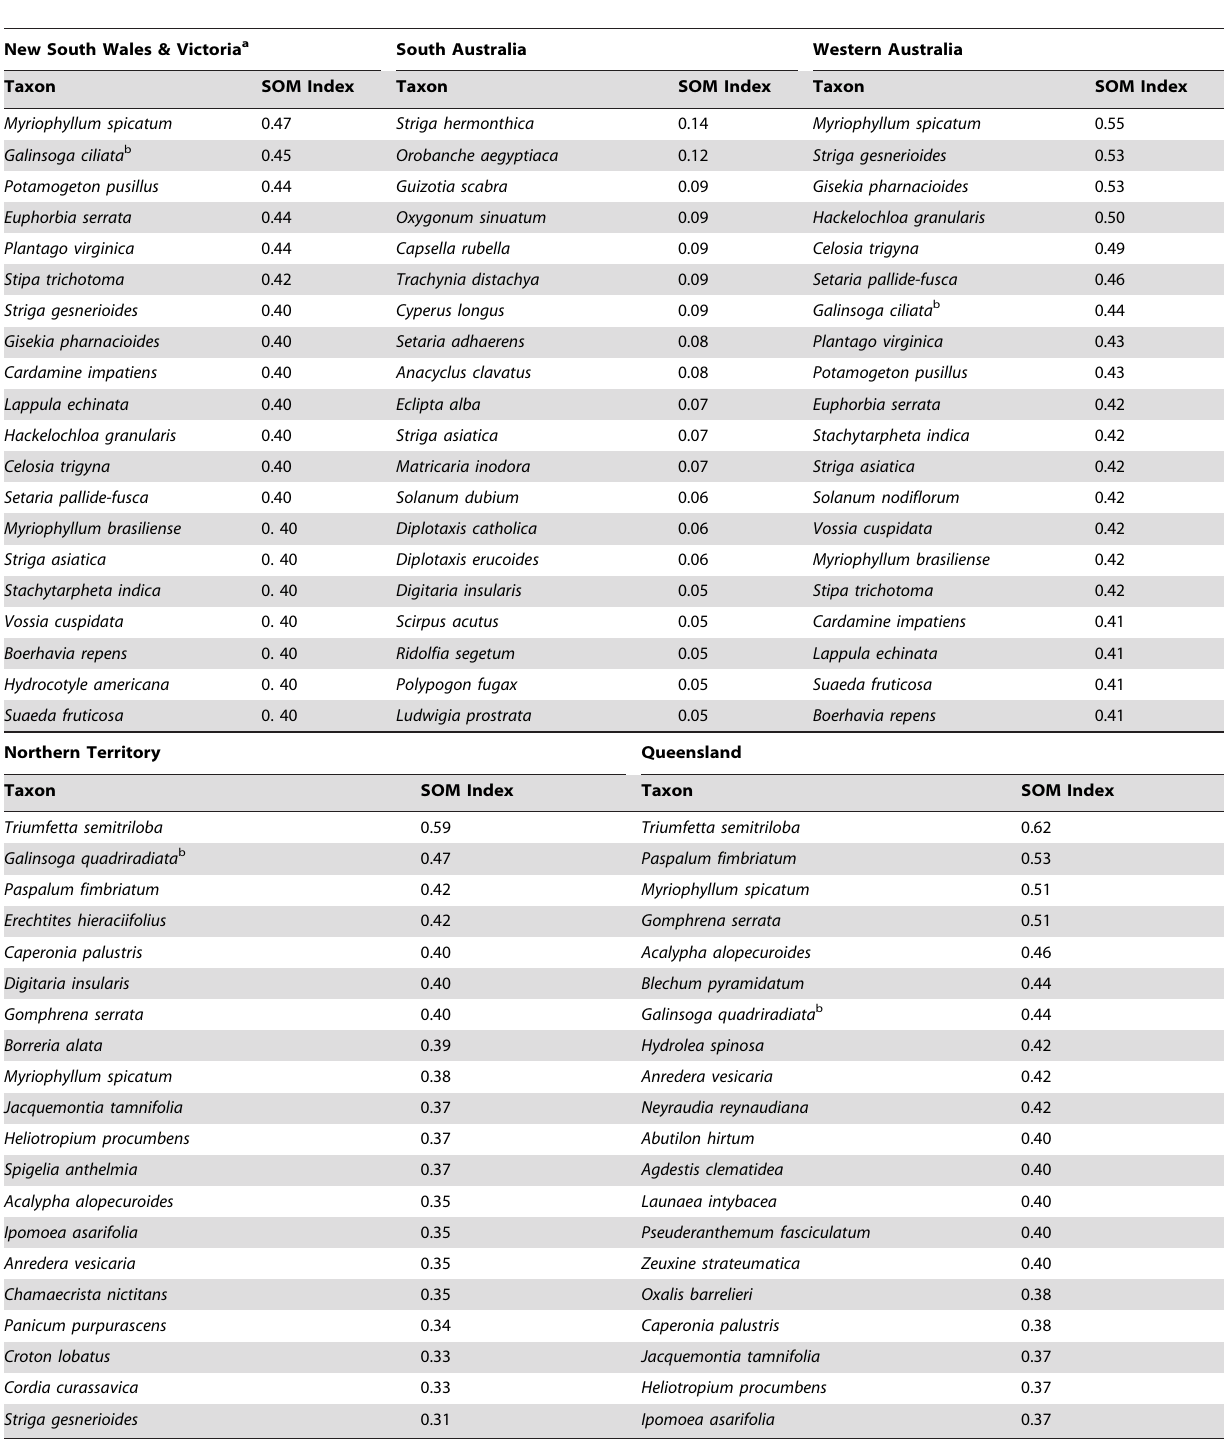
Table 2. Plant taxa absent from Australia – top 20 plant taxa for each state (except Tasmania) and Northern Territory that are currently absent from Australia, but have the highest likelihood of becoming weeds if introduced (for full list see Table